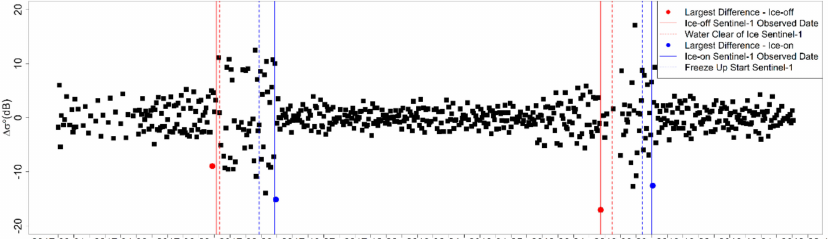
Figure 4. Identification of the largest and last backscatter decrease for a pixel during the break-up and freeze-up (red and blue circle) periods, and the relation to the observed ice-on and ice-o ff dates (solid lines represent observed dates from Sentinel-1).